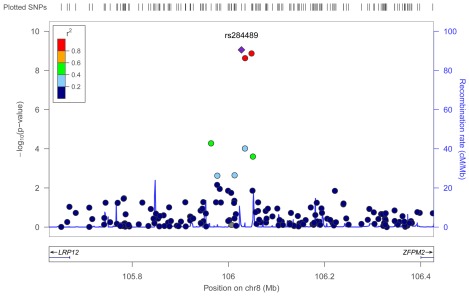
Meta-analysis results for SNPs associated with normal pressure glaucoma (NPG) (IOP <22 mm Hg) located in the 8q22 region.The most significant SNP (rs284489, p = 8.8×10−10) is indicated with a solid diamond.